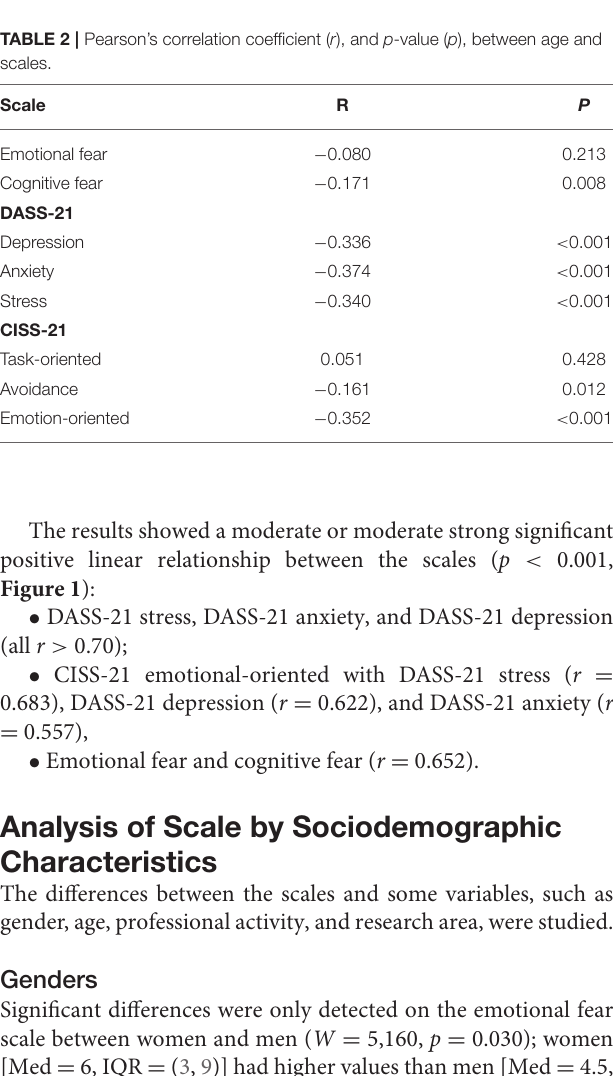
TABLE 2 | Pearson’s correlation coefficient ( r ), and p -value ( p ), between age and scales.